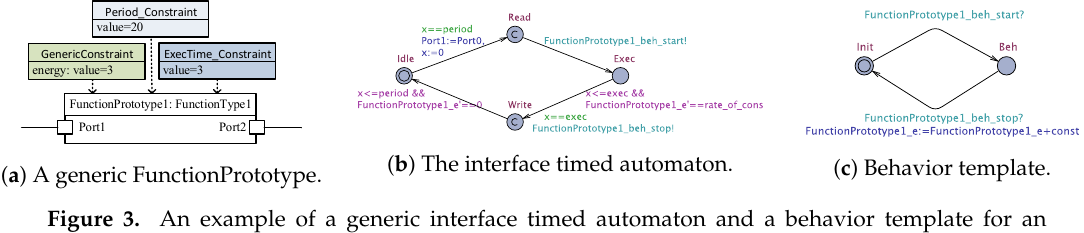
Figure 3. An example of a generic interface timed automaton and a behavior template for an EAST-ADL